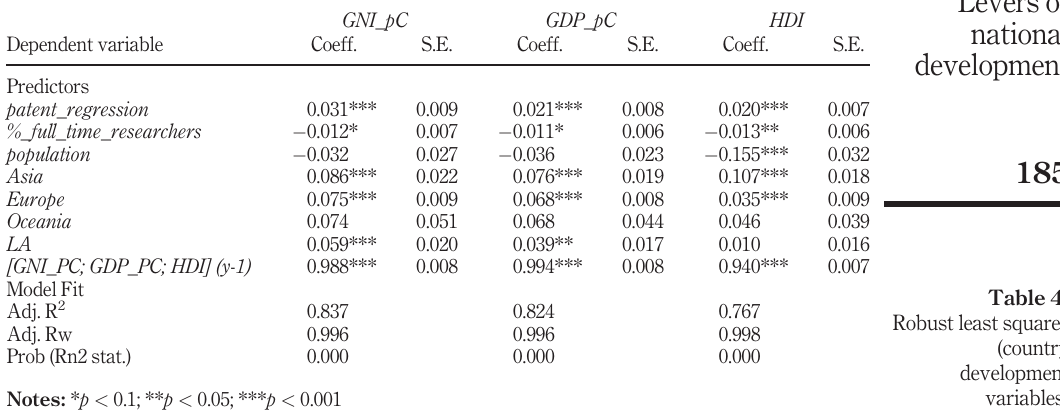
Table 4. Robust least